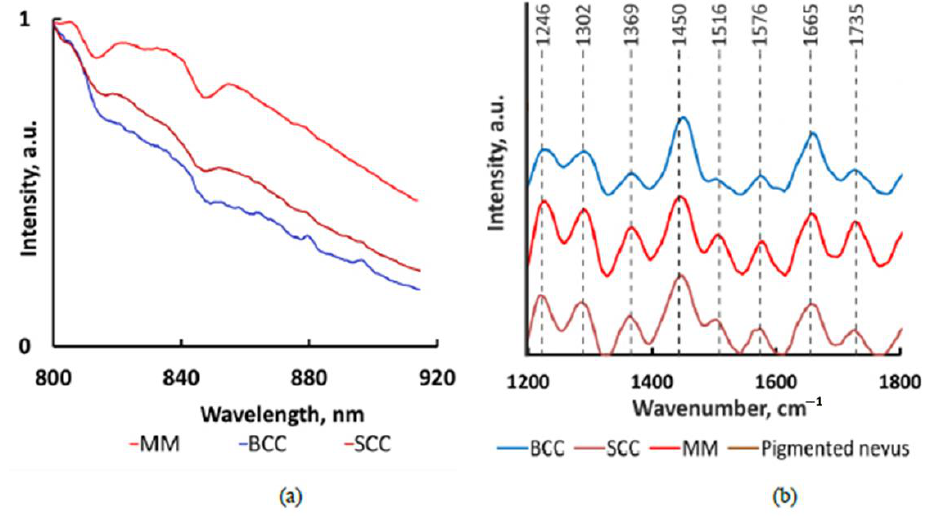
Figure 1. An example of in vivo Raman spectra before ( a ) and after ( b ) preprocessing: MM is malignant melanoma, BCC is basal cell carcinoma, SCC is squamous cell carcinoma. Adapted with permission from Ref. [13]. 2020, Y. Khristoforova.